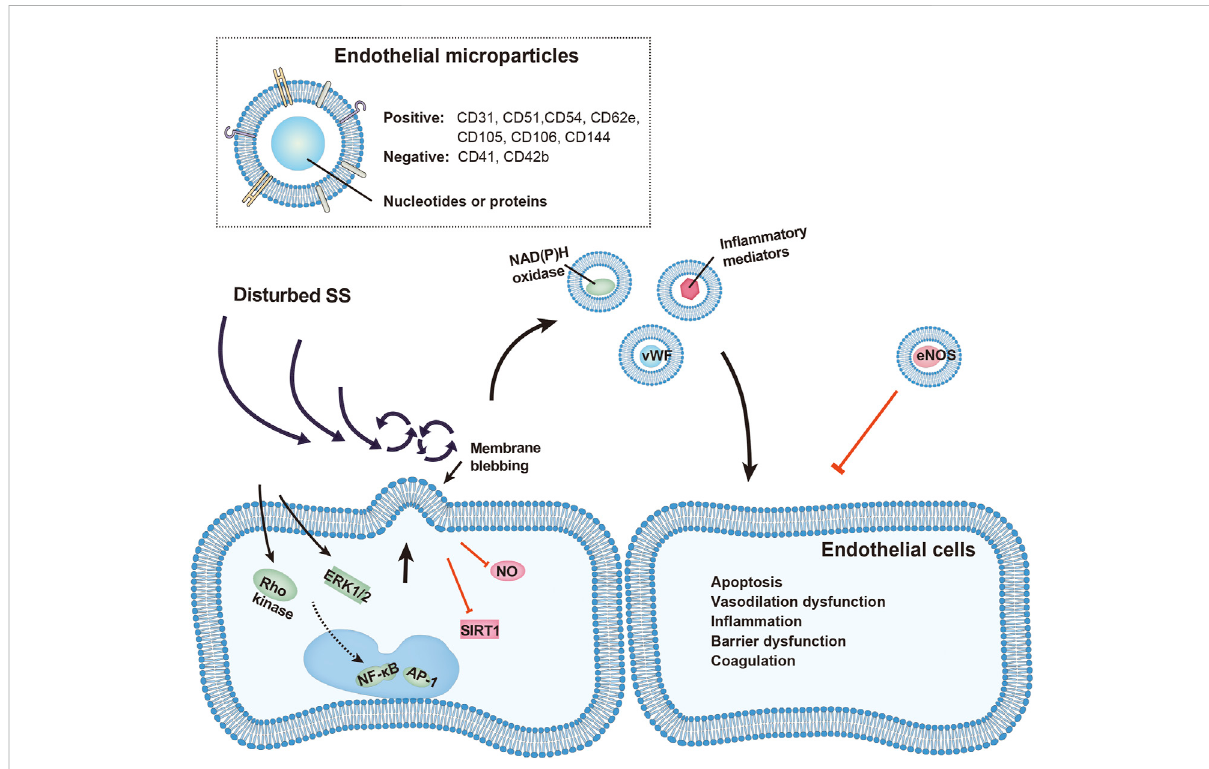
Schematic representation of vascular injury by EMPs under disturbed shear stress (SS). EMP release is increased under disturbed SS through activation of Rho kinase, ERK1/2, NF- κ b, and AP-1 pathways, or by inhibition of STIR1 and nitric oxide (NO). Released EMPs, identi fi ed by presence of endothelial and absence of platelet surface markers, carry functional proteins including von Willebrand factors, NAD(P)H oxidase, in fl ammatory mediators and eNOS. These EMPs affect nearby endothelial cells and promote vascular apoptosis, vasodilation dysfunction, in fl ammatory response, barrier dysfunction and local